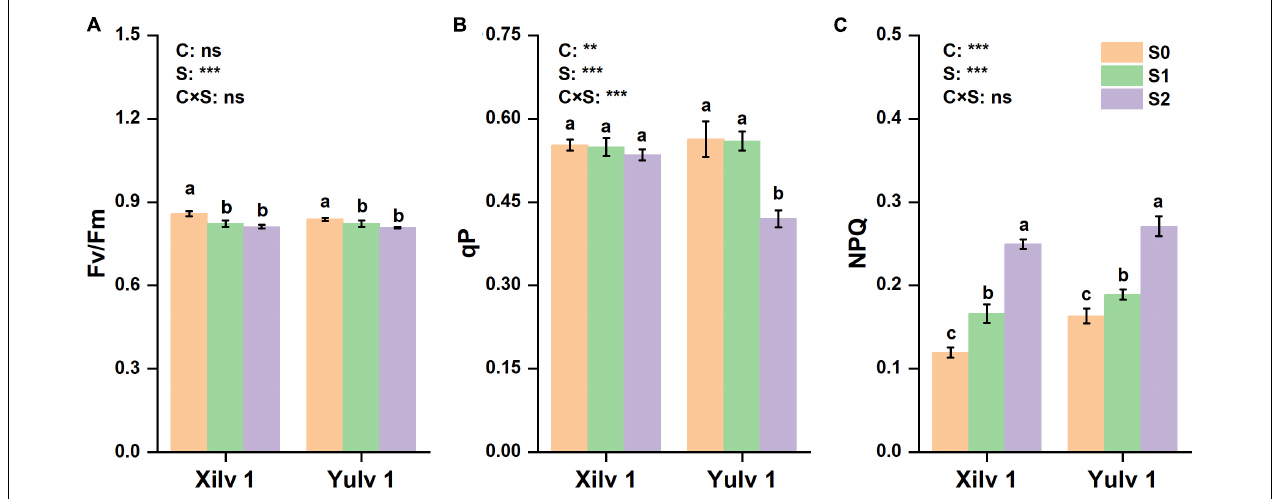
FIGURE 5 | Effect of shading stress on the leaf chlorophyll (Chl) fluorescence parameters in mung bean. (A) The maximal photosystem II (PSII) quantum yield; (B) photochemical quenching; and (C) non-photochemical quenching (NPQ). Values followed by a different letter are significantly different at p < 0.05. S0, no shading; S1, moderate shading; and S2, severe shading. ** and *** significant at the 0.01 and 0.001 probability levels, respectively. ns, no significant difference.